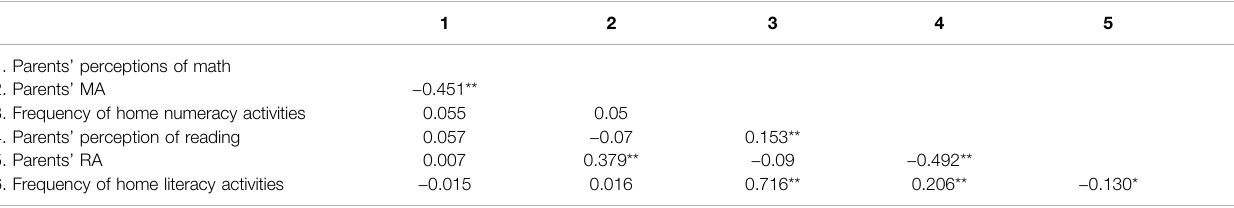
TABLE 1 | Bivariate correlations among the HLE